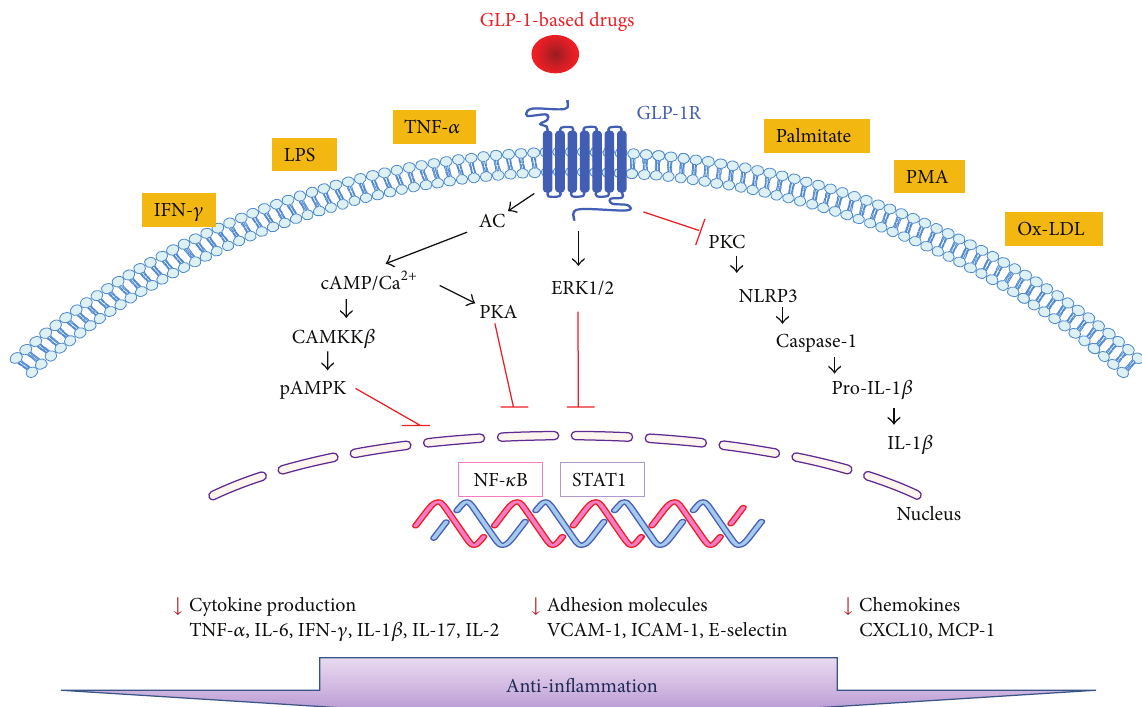
Figure 1: Molecular signals underlying the anti-inflammatory effects of GLP-1-based drugs. DPP-4 inhibitors increase GLP-1 levels in plasma. GLP-1 and GLP-1 receptor (GLP-1R) agonists bind to the GLP-1 receptor, which blocks PKC or NF- 𝜅 B activation and subsequent expression of NLRP3, IL-1 𝛽 , TNF- 𝛼 , IL-6, VCAM-1, IFN- 𝛾 , and MCP-1. In addition, GLP-1R signaling activates cAMP/Ca 2+ , CAMKK 𝛽 , and pAMPK, which induces anti-inflammatory effects on monocyte